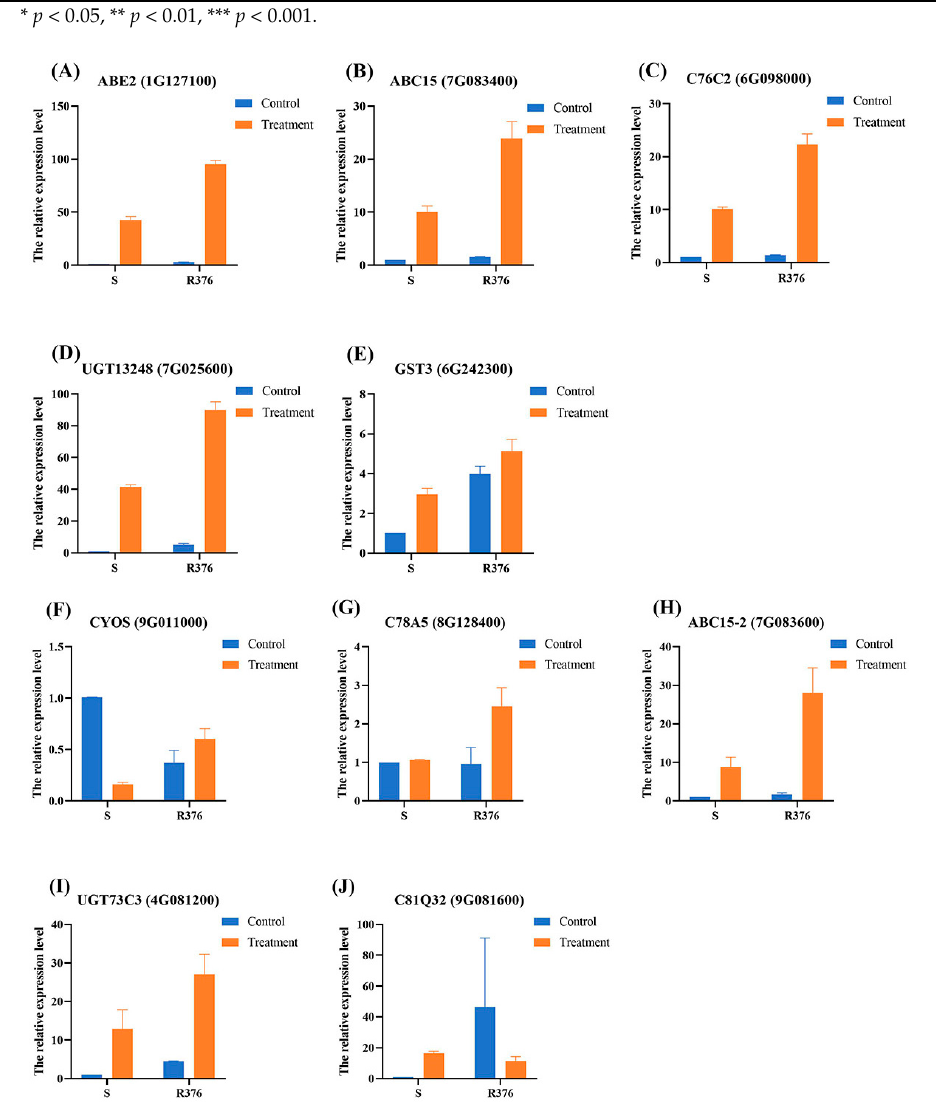
Figure 4. Relative expression of ten candidate genes in S and R376 populations before (Control) and after (Treatment) nicosulfuron treatment. The ten candidate genes are ABE2 ( A ), ABC15 ( B ), C76C2 ( C ), UGT13248 ( D ), GST3 ( E ), CYOS ( F ), C78A5 ( G ), ABC15-2 ( H ), UGT73C3 ( I ), C81Q32 ( J ).